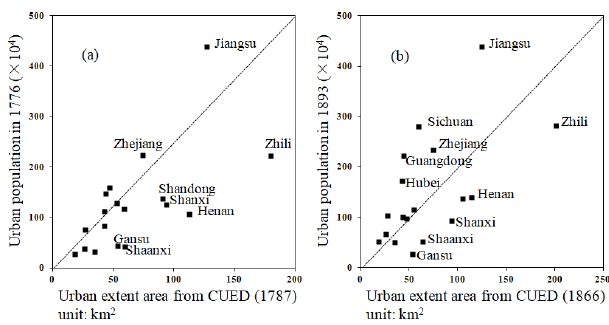
Figure 9. Comparison of the urban population in 1776 and 1893 (UPD) and the urban area in 1787 and 1866 from